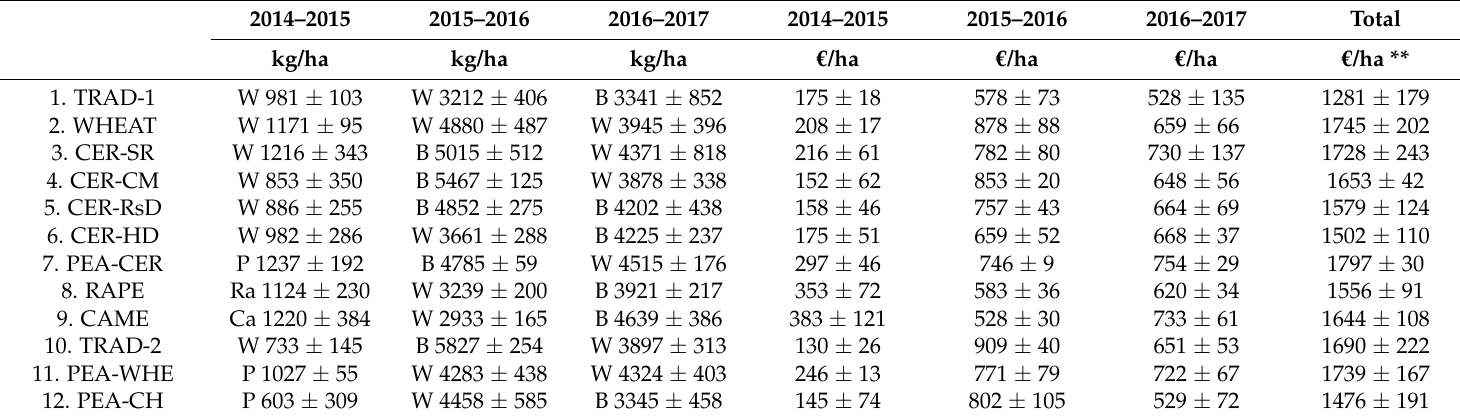
Table 6. Yield (kg/ha) (+SE) obtained in each management each growing